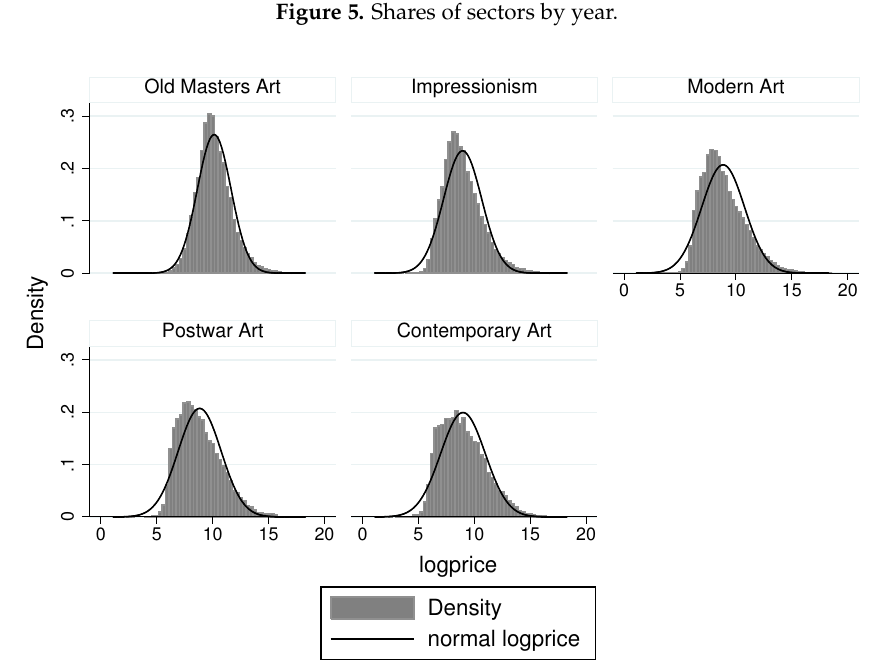
Figure 6. Histograms of price logarithm by